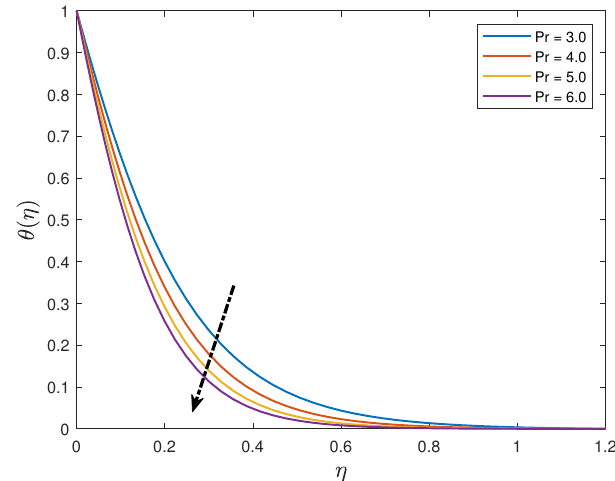
Figure 9. Influence of Pr on the nanofluid